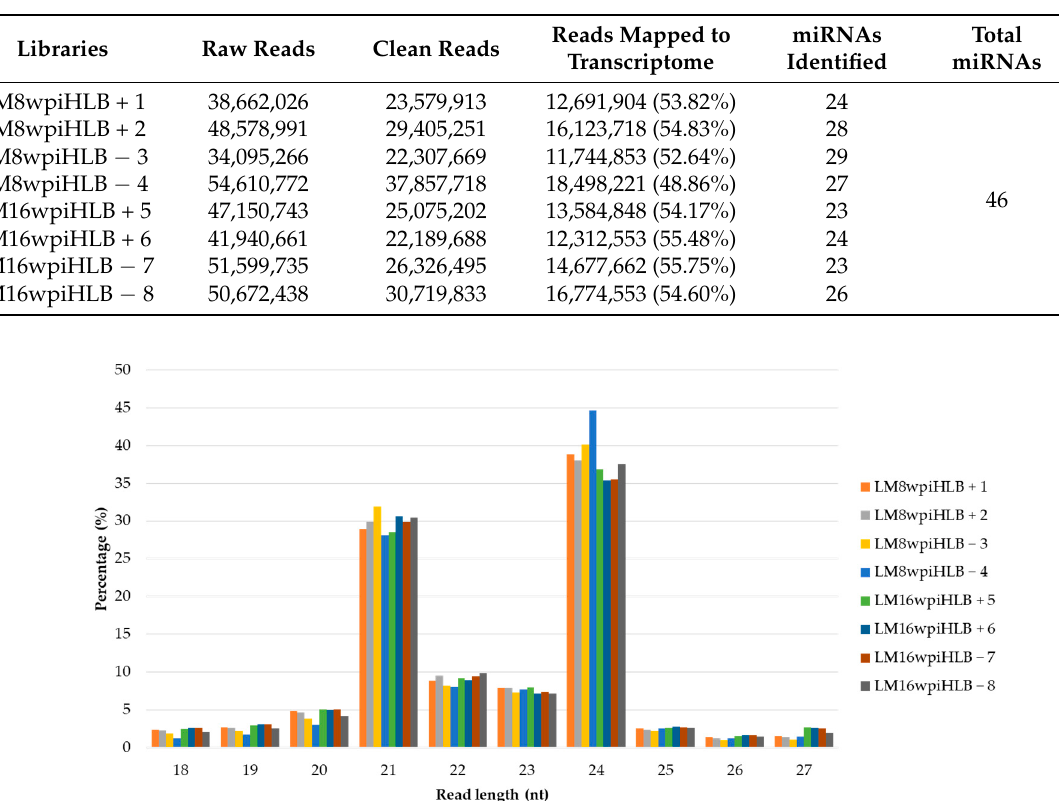
Table 1. Data summary of sRNA-Seq libraries in Citrus aurantifolia at early and late stages of Huanglongbing disease.